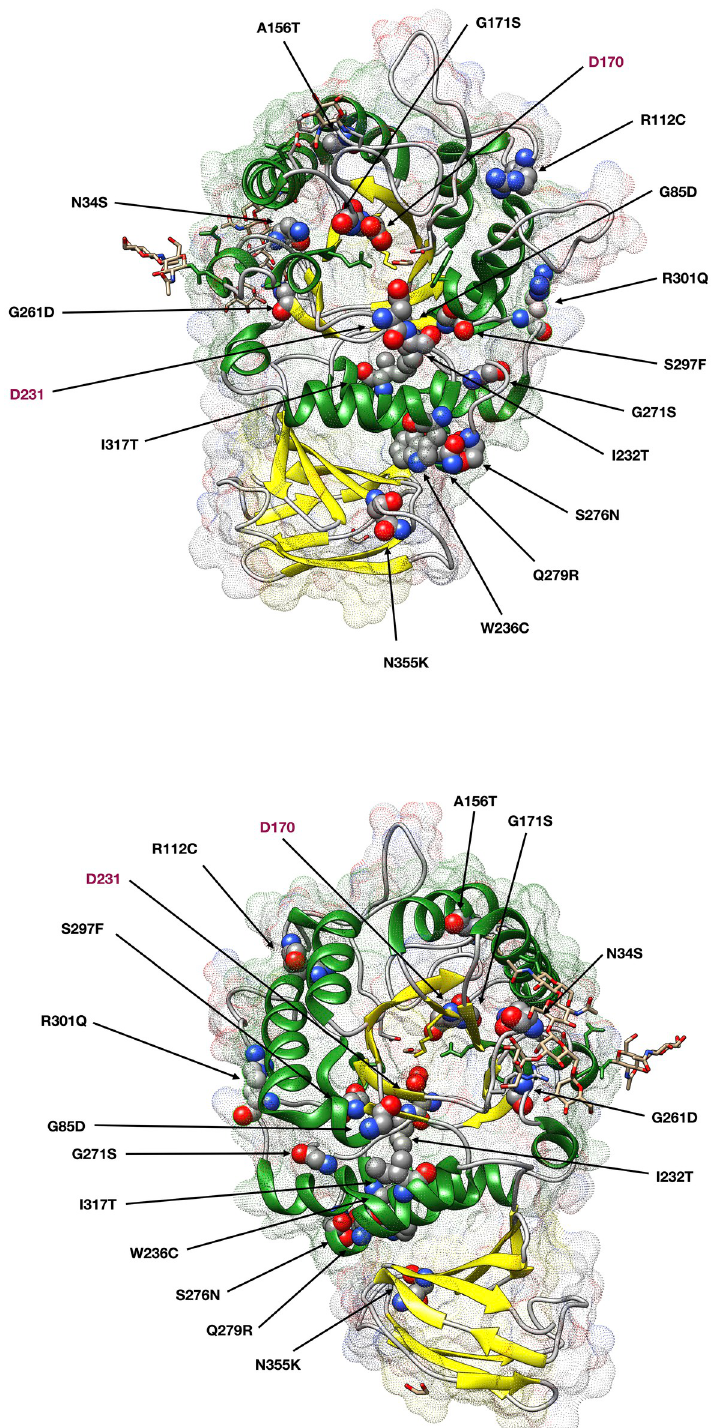
Fig 2. Structure of human GLA and positions of the amino acid substitutions resulting from the missense pathogenic variants identified in the Danish Fabry patients. The backbone is displayed as a ribbon model, and the ligand and sugars as a stick model. The amino acids involved in the substitutions and the catalytic residues (D170 and D231) are indicated as a space-filling calotte (Corey-Pauling-Koltun CPK) model. Front view (top) and back view